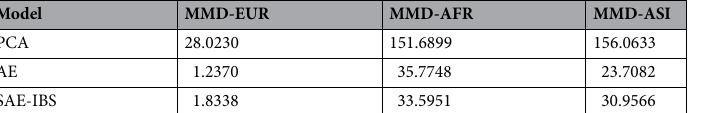
Table 1. The mean Mahalanobis distance (MMD) using eight ancestry axes between the groups of relatives and three population clusters, i.e., European (EUR), African (AFR), and Asian (ASI). The relatives are of European